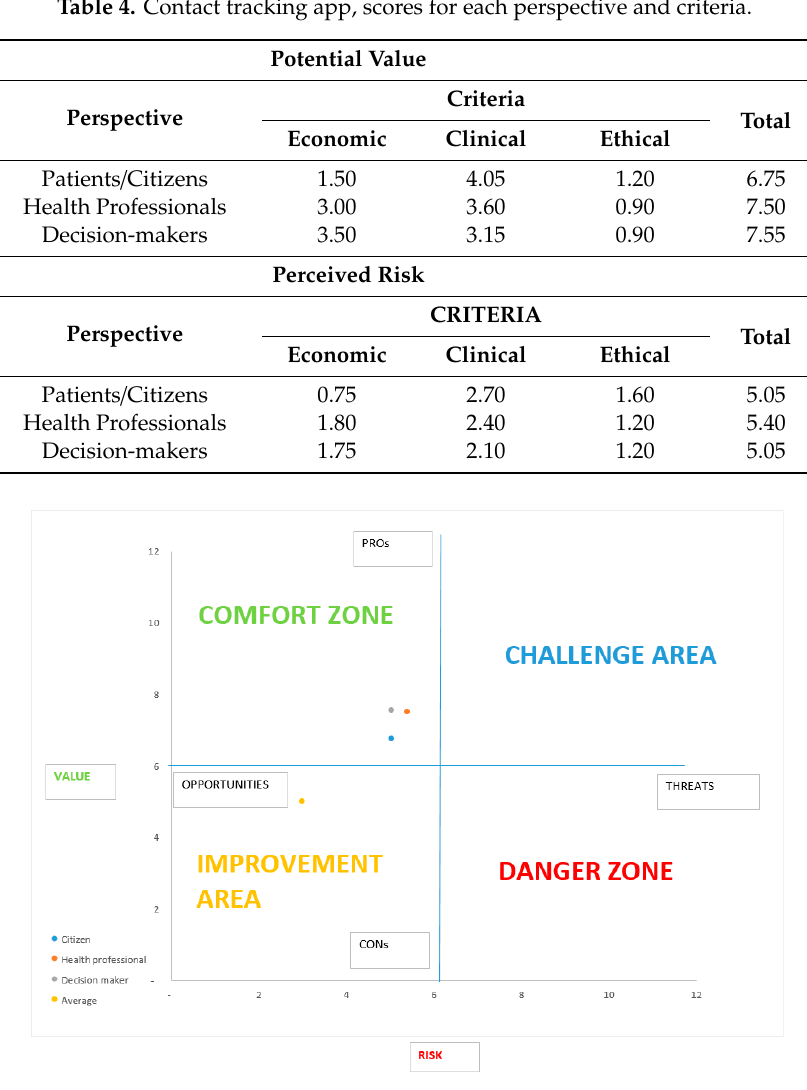
Figure 2. Contact tracking app; potential risk/perceived value graph.